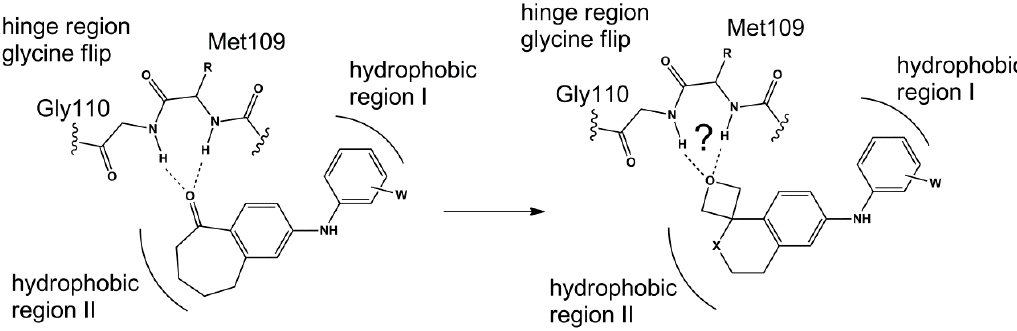
Figure 2. Schematic of the interactions of benzosuberone and oxetane analogs in the hinge region.